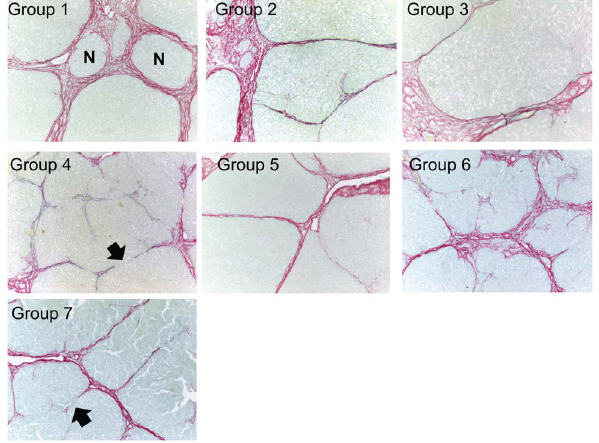
Figure 6. Representative histology of Sirius red stained liver sections from experiment described in Figure 4. A photomicro- graph was chosen from each experimental group that was approxi- mately equal to the mean of the group for percent area stained with Sirius red. N=nodule; Closed arrows=incomplete (broken) strands of bridging fibrosis.